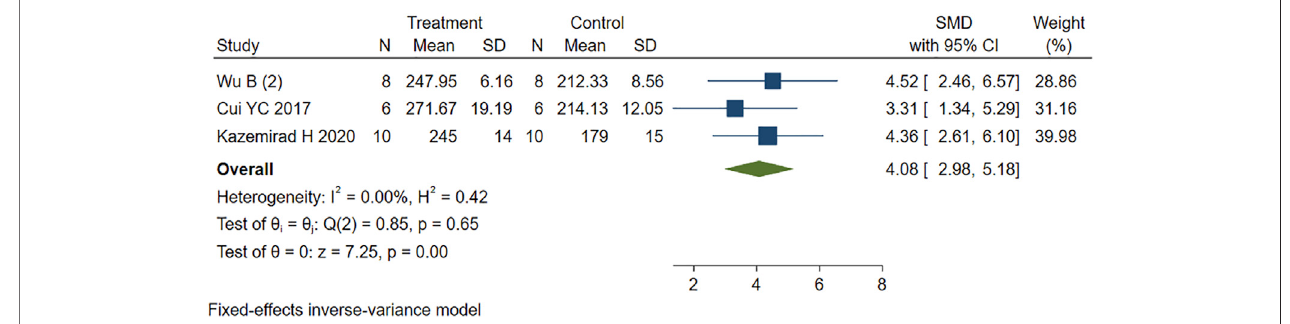
FIGURE7| Forestplottostudytheeffect ofPEonheartrate.PEreducedheartrateinMIRIanimalscomparedtocontrolgroup(SMD=4.0895%CI:2.98to5.18, p < 0.001). The dark squaresrepresent the standardized mean difference(SMD) for each study. The diamonds represent the pooled SMD. 95% ofthe CIs are indicated by lines. The analysis was conducted using a fi xed-effects